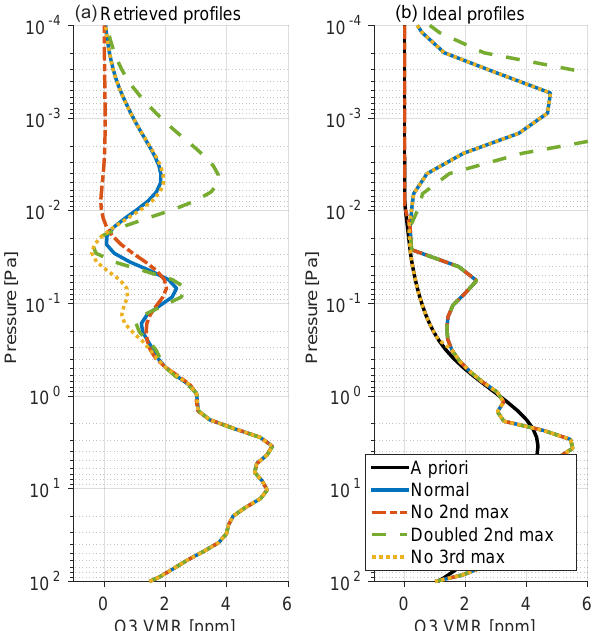
Figure 17. Ozone profiles (a) retrieved from spectra generated with ARTS using different ideal profiles (b) . The ideal profile is from SD-WACCM and shows the three ozone maxima. It was modified to have no second or third maximum or a doubled second